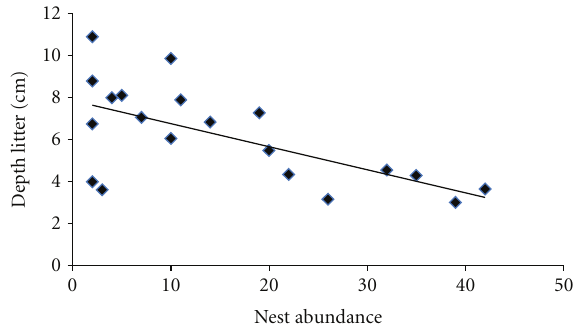
Figure 5: Relationship between depth litter (cm) and nest abunda- nce in twigs of the leaf litter di ff ered between the forest types.